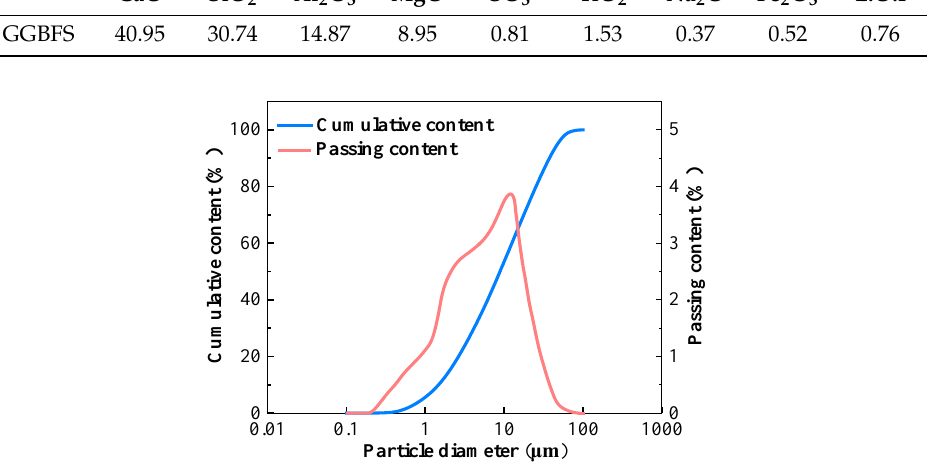
Figure 1. Particle size distribution of GGBFS.